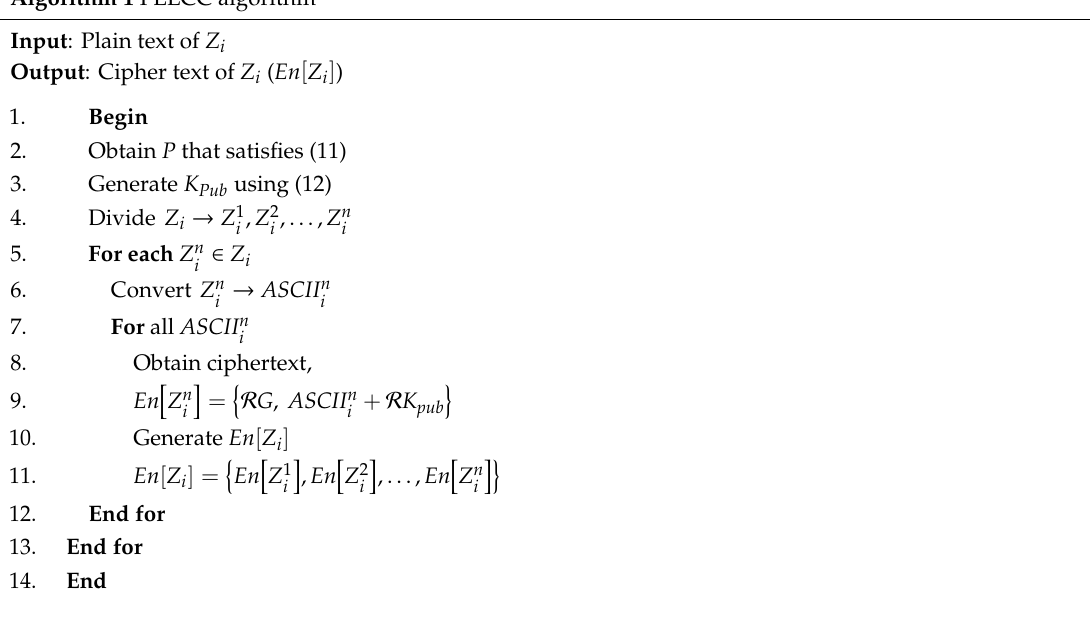
Algorithm 1 PEECC